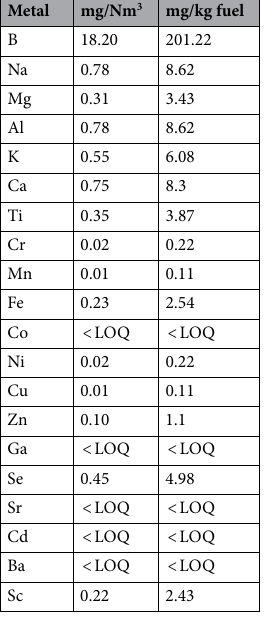
Table 9. Concentration of metals in emissions and factor emission.